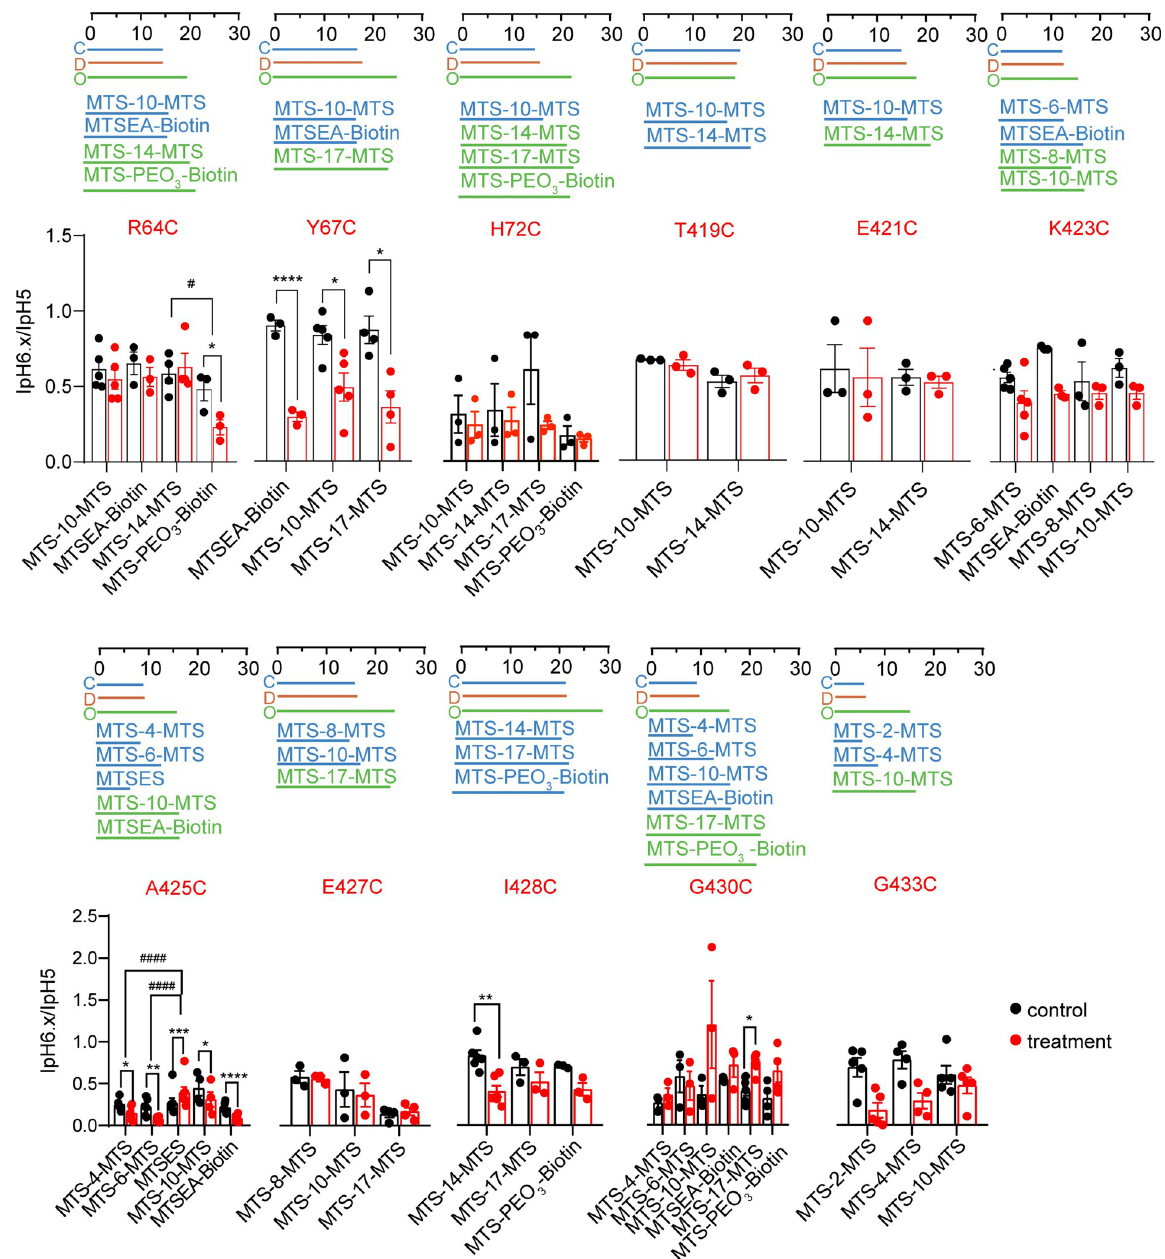
Fig 7. Effects of MTS reagents on the pH dependence of single mutants in the wrist and TM domains. Data were obtained from two- electrode voltage-clamp of Xenopus oocytes expressing the indicated mutants, clamped to -60mV. The IpH6.x/IpH5.0 ratio was determined in each cell before and after exposure to the MTS reagents and is indicated with black symbols for the control condition, and with red symbols for the condition after exposure to the MTS reagent. Changes in the IpH6.x/IpH5.0 ratio indicate that the MTS reagent affected the pH dependence. The pH6.x was pH6.6 for mutants Y67C, E427C, G430C and G433C, and pH6.4 for R64C, H72C, T419C, E421C, K423C, A425C and I428C. Differences between the control and the MTS condition are indicated as � , p < 0.05; �� , p < 0.01, ��� , p < 0.001 and ���� , p < 0.0001 (paired t- test) and between cross-linkers and matching monovalent MTS reagents as #, p < 0.05 and ####, p < 0.0001 (Ordinary one-way ANOVA and Tukey post-hoc test). Above the data, a scale (in units of Å ) and horizontal lines illustrate the distance between C β -atoms (Ca-atoms in Gly) of the mutated residues in the closed, open and desensitized state, and the length of the used MTS cross-linkers and monovalent MTS reagents used with the mutant. The color code is blue for closed, red for desensitized, and green for open; the colors of the reagents were chosen according to the best match between the length of the reagent and the distance between the two residues. The color of the mutant label matches that of the domain in which the mutation is located.